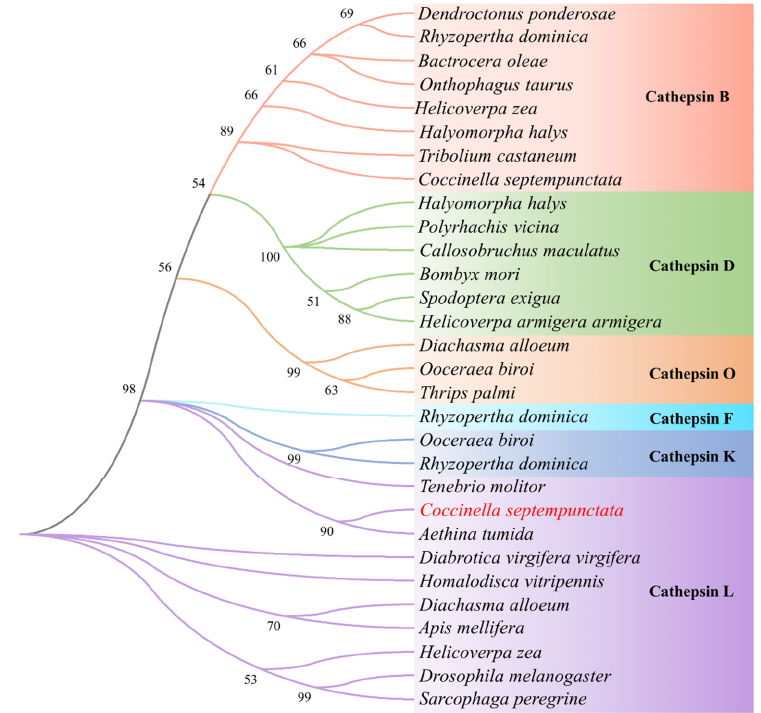
Figure 2. Phylogenetic tree of cathepsin proteins from C. septempunctata and other insects. The phylogenetic tree was constructed based on amino acid sequences of cathepsin using the WAG-based neighbor-joining method with 1000 bootstraps. C. septempunctata cathepsin L was highlighted in red.